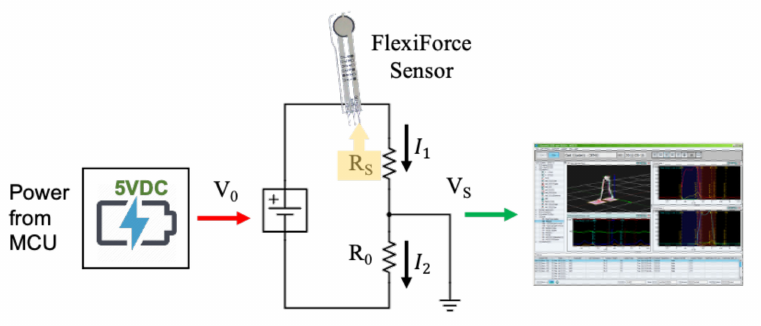
Figure 3. FlexiForce sensor interface with the Codamotion system to transfer all 14 sensor